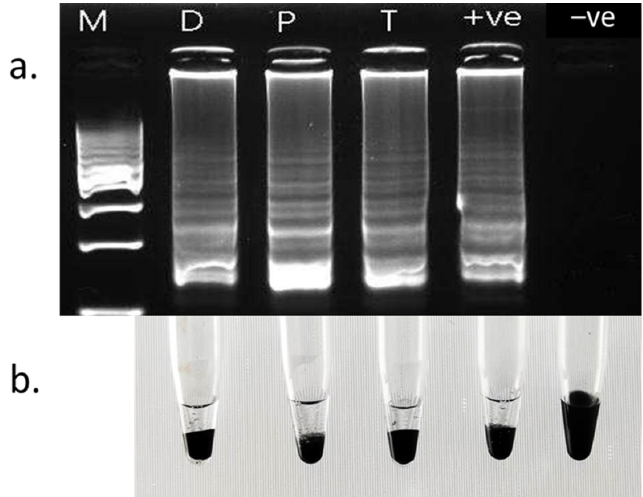
Figure 5. Analysis of LAMP amplification products by gel electrophoresis ( a ) and carbon flocculation assay ( b ). +ve = positive control using R. syzygii subsp. celebesensis (GenBank No. CP019911.1). − ve = negative control without DNA template. LAMP reactions were subsequently loaded to agarose gel and separated by electrophoresis. M = 100 bp DNA marker. Flocculation results showed positive reaction for the samples of D, P, T, and +ve with DNA particles flocculated and settled on the bottom of the tube but no reaction in negative control. D = leaves, P = leaf midrib, and T = stalk. Each figure represents least 3 experimental